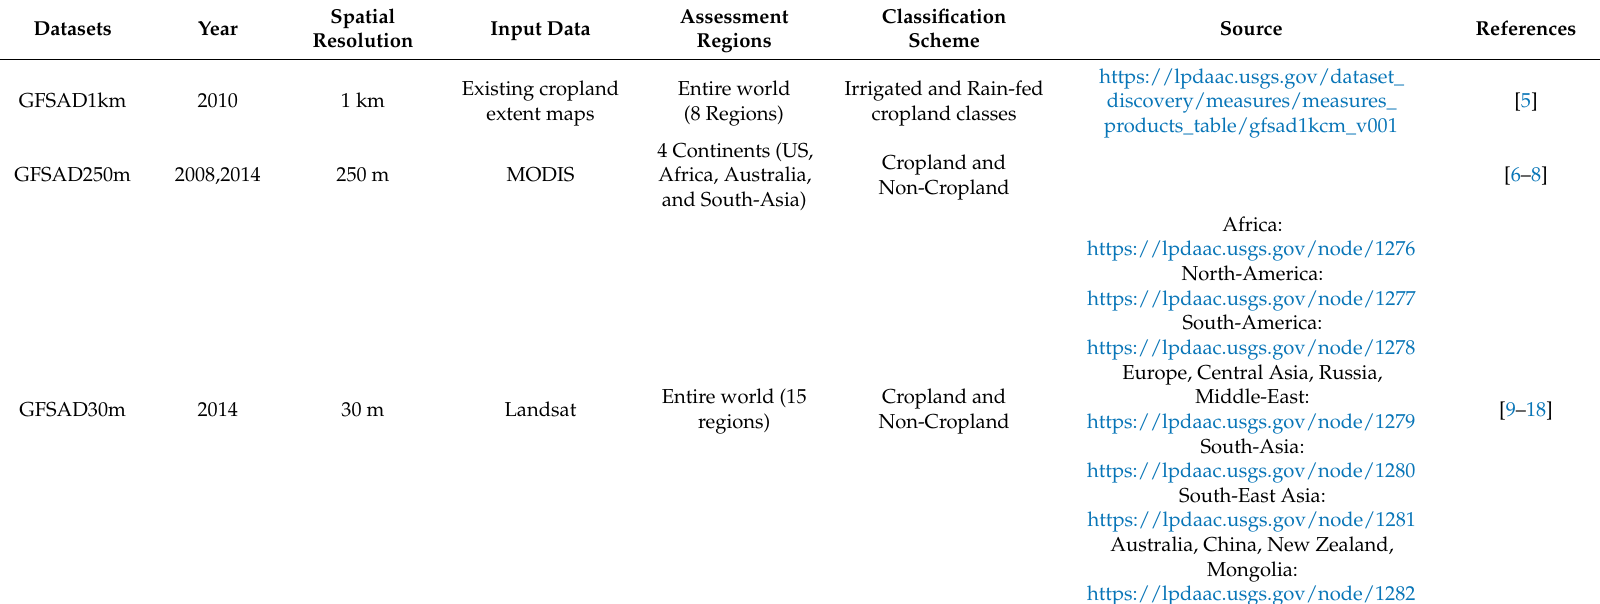
Table 2. Description of the three different GFSAD cropland extent